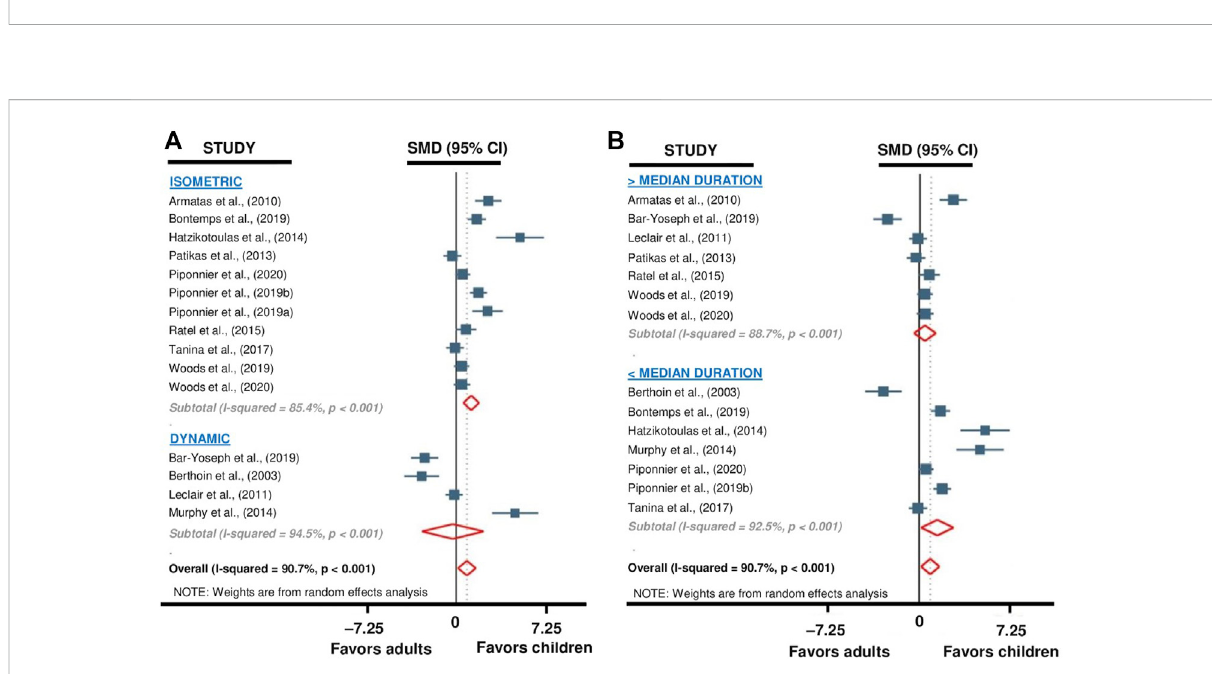
FIGURE 3 Forest plot from the subgroup meta-analysis reporting the in fl uence of 1) exercise modality (i.e., isometric or dynamic; (A) and 2) exercise duration (B) on TTF differences between children and adults. Raw SMDs (with 95% con fi dence intervals) and %weights of the meta-analyzedstudies are given in Figure